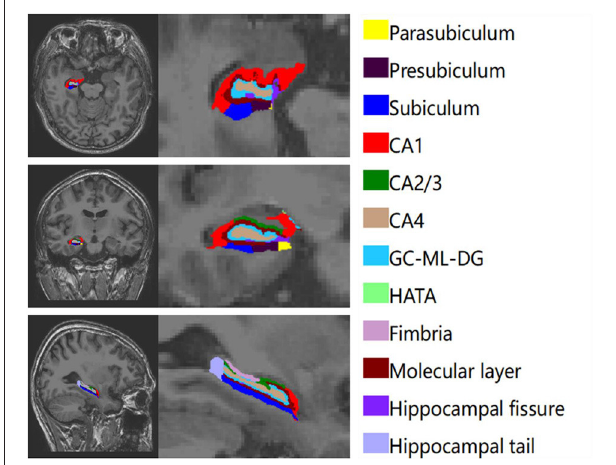
FIGURE 1 | A simple of left hippocampal subfield automated